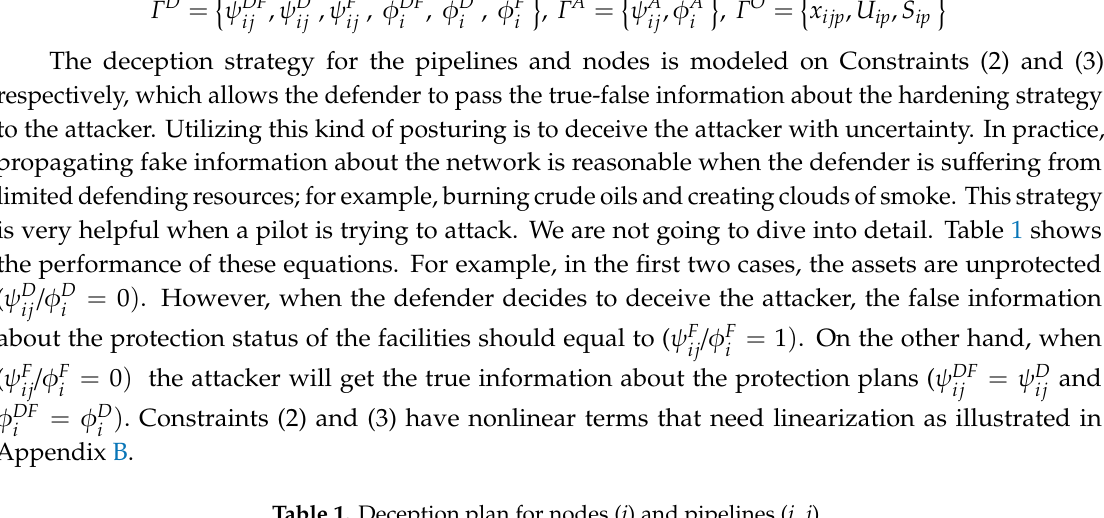
Table 1. Deception plan for nodes ( i ) and pipelines ( i , j